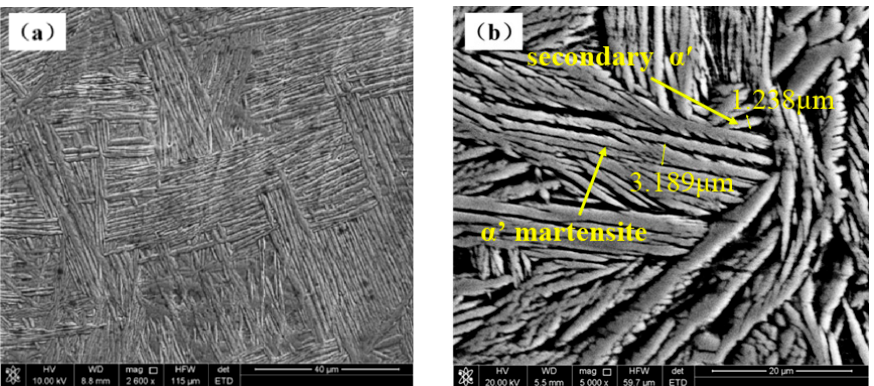
Figure 8. Net basket structure in underwater welds: ( a ) net basket structure; ( b ) local magnification. The metallographic organization near the fusion line is shown in Figure 9. Figure 9c,d are local magnifications of Figure 9a,b, respectively. The heat-affected zone is composed of α (cid:48) martensite and the initial α phase. The reason is that the heat affected zone is second only to the weld during the welding process. The heat affected zone temperature increases with the decrease of the distance from the weld. In the heating process of the heat affected zone near the weld, the TC4 substrate is heated. The highest temperature of the TC4 substrate reaches the transformation temperature of α phase → β phase. Then, the β single-phase zone is formed. During the cooling process, β phase forms α (cid:48) martensite through shear. During the heating process of the heat-affected zone far away from the weld, the temperature is relatively low. Only part of the α phase undergoes the allotropic transformation from α phase to β phase, forming a dual phase zone of β + α . During the cooling process, β phase forms α (cid:48) martensite phase through shear. The α phase is not transformed. So, a mixed structure of α (cid:48) martensite phase and initial α phase is formed.